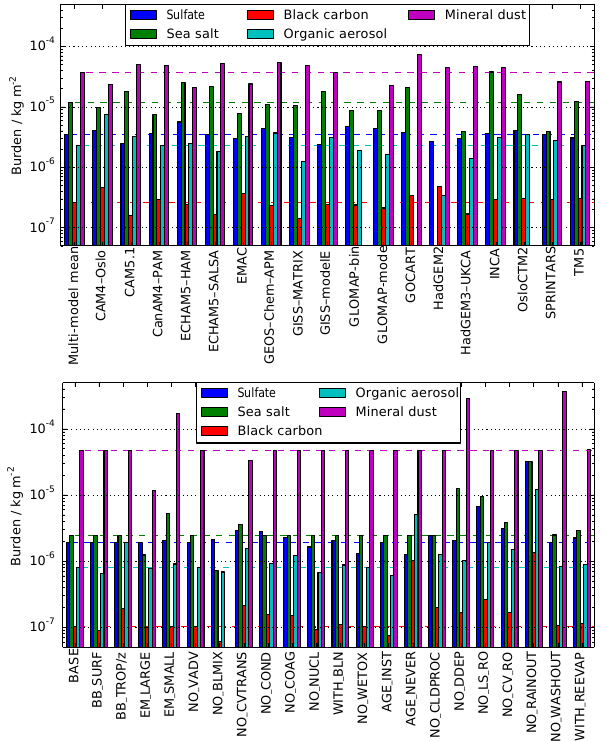
Figure 2. Annual- and global-mean column burdens of sulfate, sea salt, black carbon, organic aerosol and mineral dust from the Aero- Com Phase II models (top) and HadGEM3–UKCA sensitivity-test simulations (bottom). The dashed lines represent the multi-model geometric mean (top panel) and the values from the BASE simula- tion (bottom panel) to aid